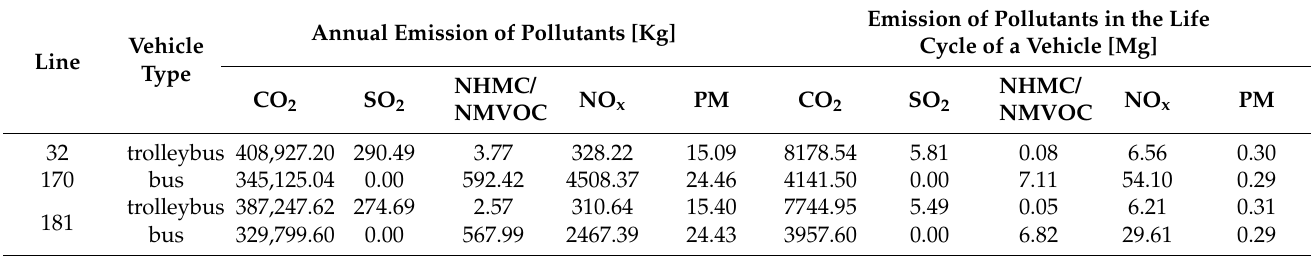
Table 6. Annual emission of pollutants and emission in the life cycle of public transport vehicles on the analysed lines.